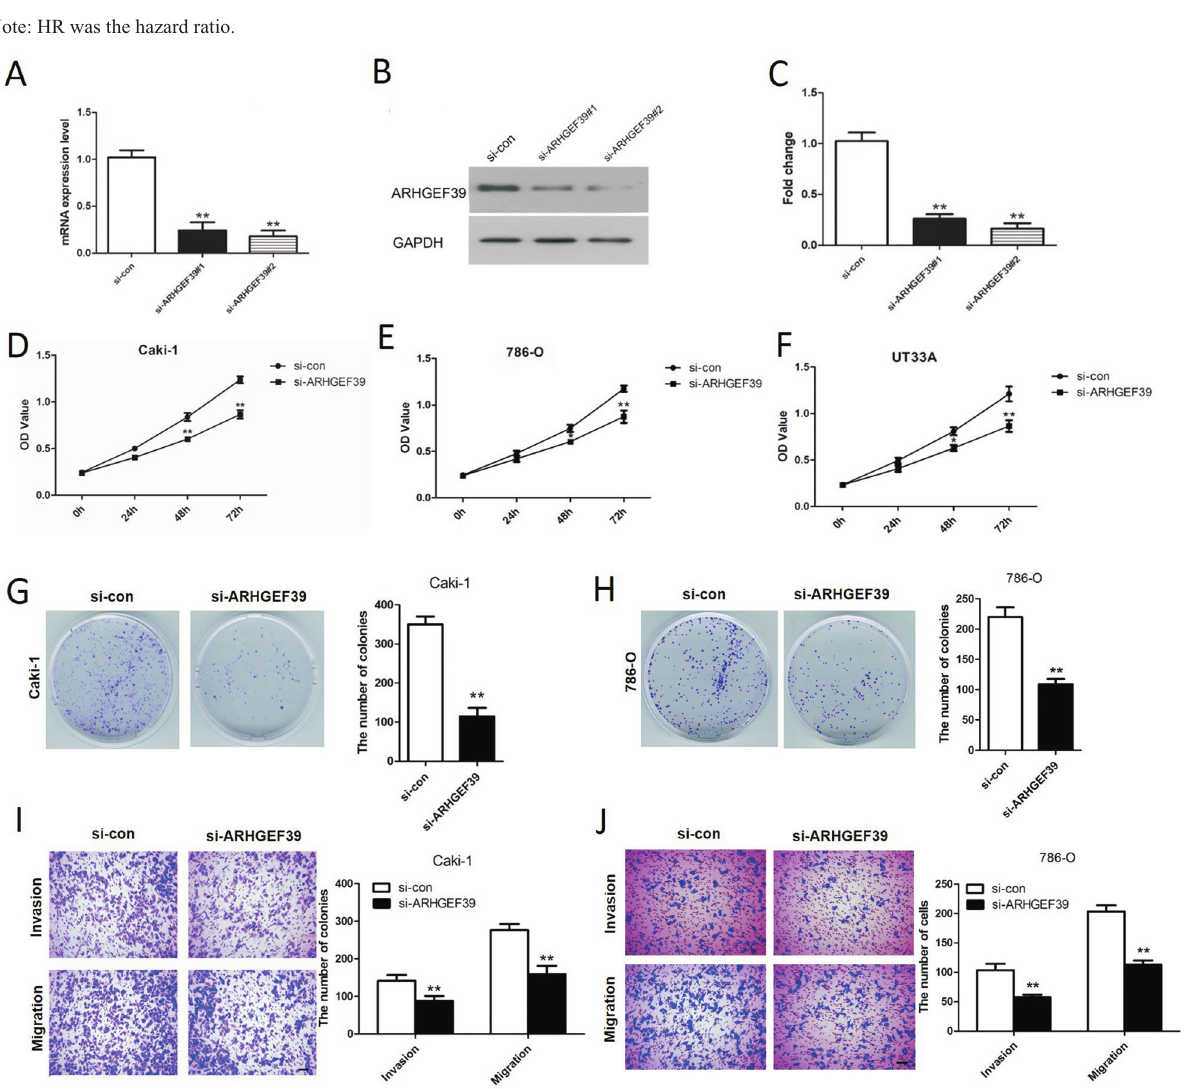
Figure 3 - ARHGEF39 knockdown inhibited the viability, migration and invasion of ccRCC cell. A) The mRNA expression of ARHGEF39 in Caki-1 cells transfected with si-con, si-ARHGEF39#1 and si-ARHGEF39#2 were detected by qRT-PCR assay, **p < 0.01. B-C) The ARHGEF39 protein ex- pression in Caki-1 cells transfected with si-con, si- ARHGEF39#1 and si-ARHGEF39#2 were detected by Western blotting assay, **p < 0.01. D-F) The viabilityofCaki-1,786-OandUT33Acellswithdown-regulatedARHGEF39wasmeasuredbyCCK8assay,*p<0.05,**p<0.01. G-H) Theviabilityof Caki-1 (G) and 786-O (H) cells in si-ARHGEF39 group was notably lower than that in si-con group which was examined by colony formation assay, **p < 0.01. I-J) The motility of Caki-1 (I) and 786-O (J) cells transfected with si-con or si-ARHGEF39 was detected by Transwell invasion and migration as- says, **p <